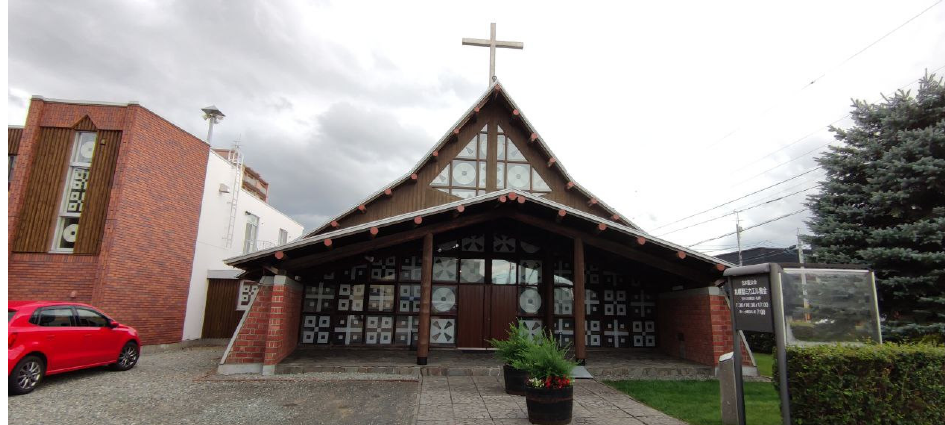
Figure 16. View of Saint Michael Church by Raymond in Sapporo.